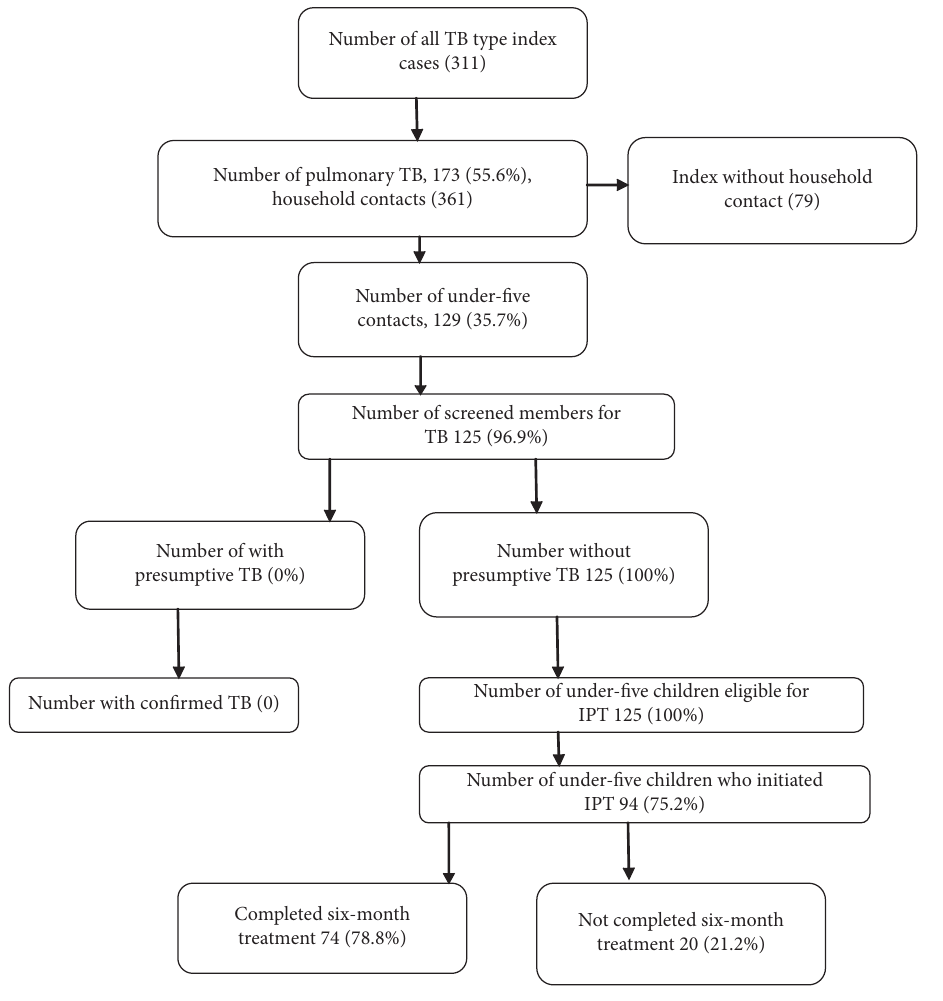
Figure 1: Under-five child contact screening in Addis Ababa health facility, 2019. Table 1: Characteristics of index cases of the child contacts by uptake of IPT,